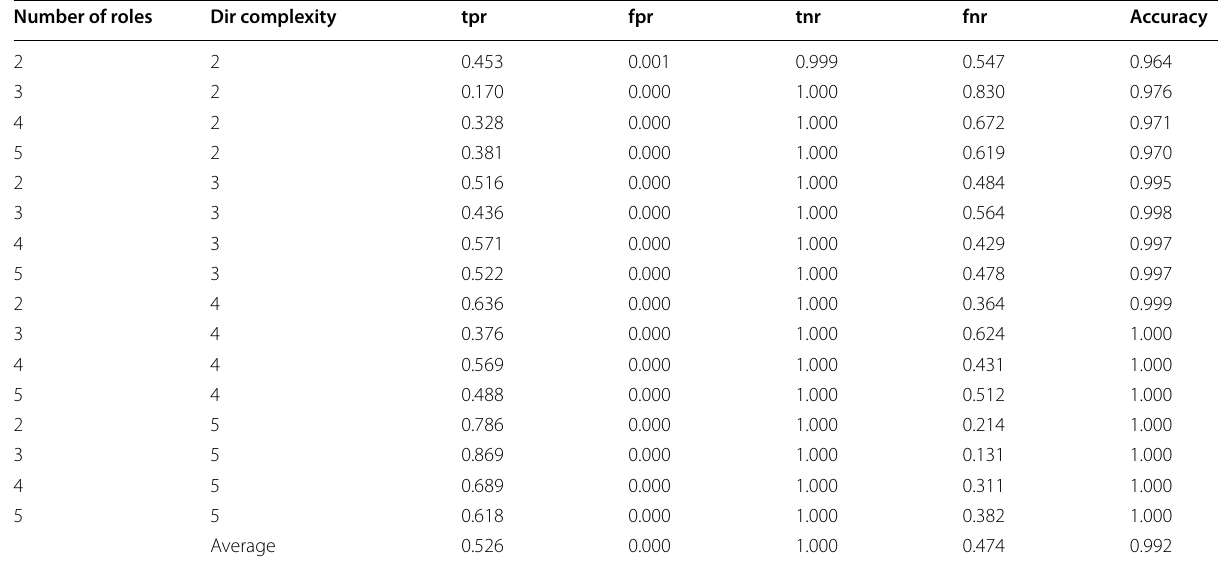
Table 3 Average accuracy values by role and directory size Number of roles